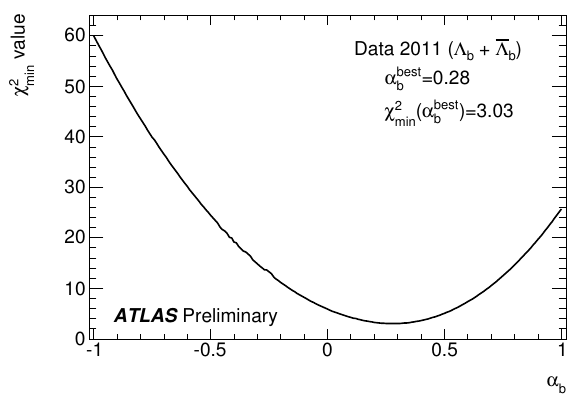
Figure 7. The conditional χ 2